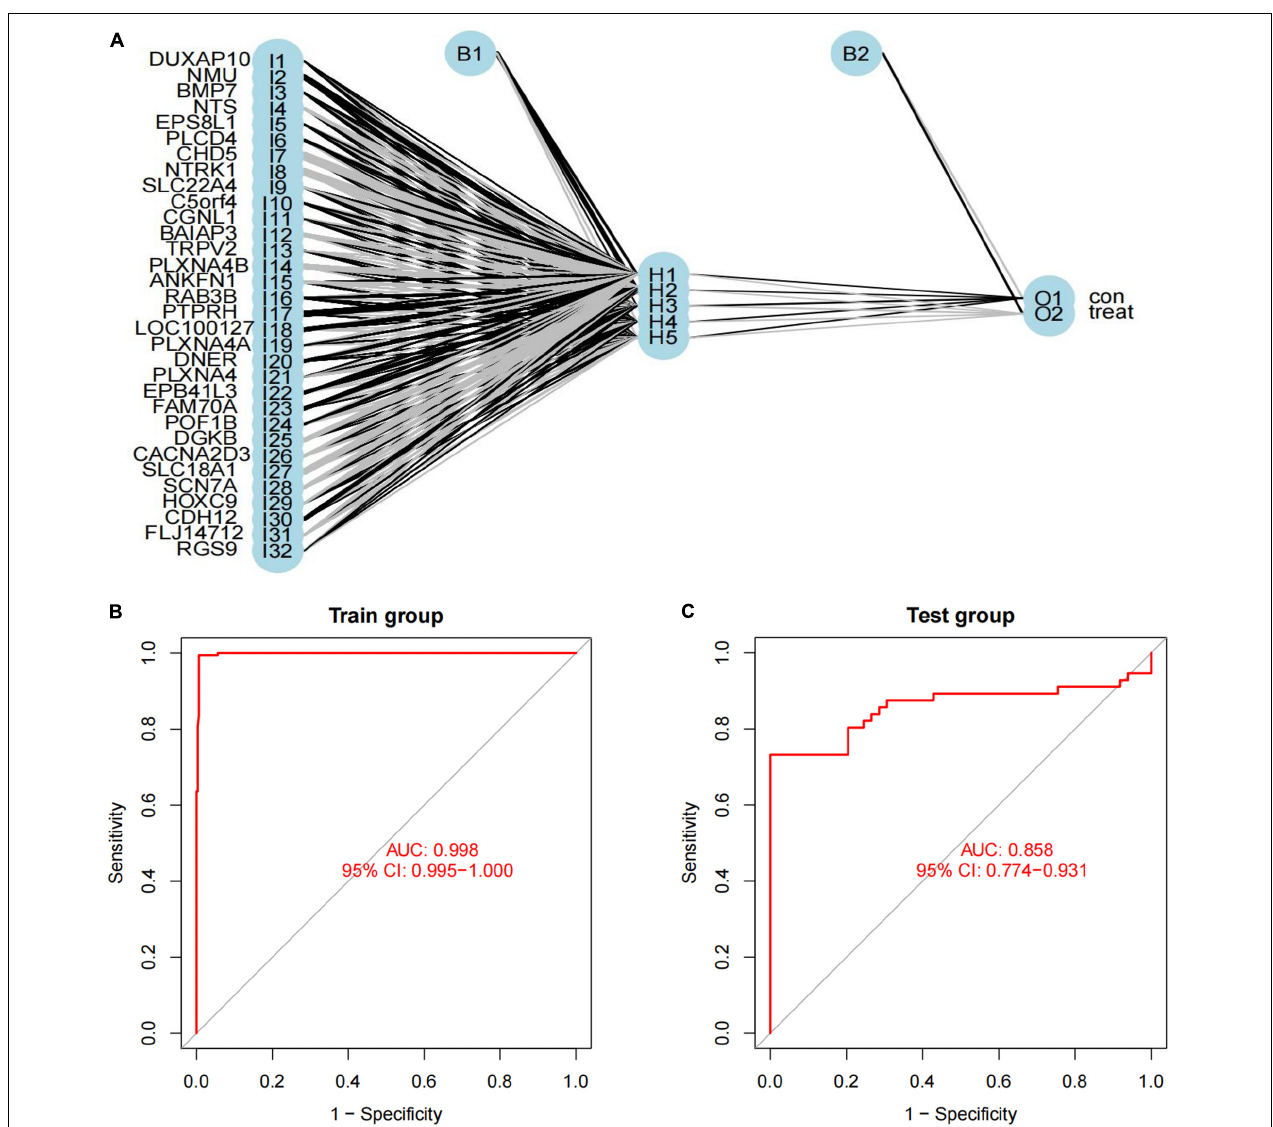
FIGURE 6 | Construction of artificial neural network (ANN) model. (A) ANN model has 30 inputs, 5 hidden neurons, and 2 outputs. In this case, the 30 inputs represent the category values of 30 feature DEGs; (B,C) the receiver operating characteristic curve of the predictive model in (B) training dataset and (C) validation